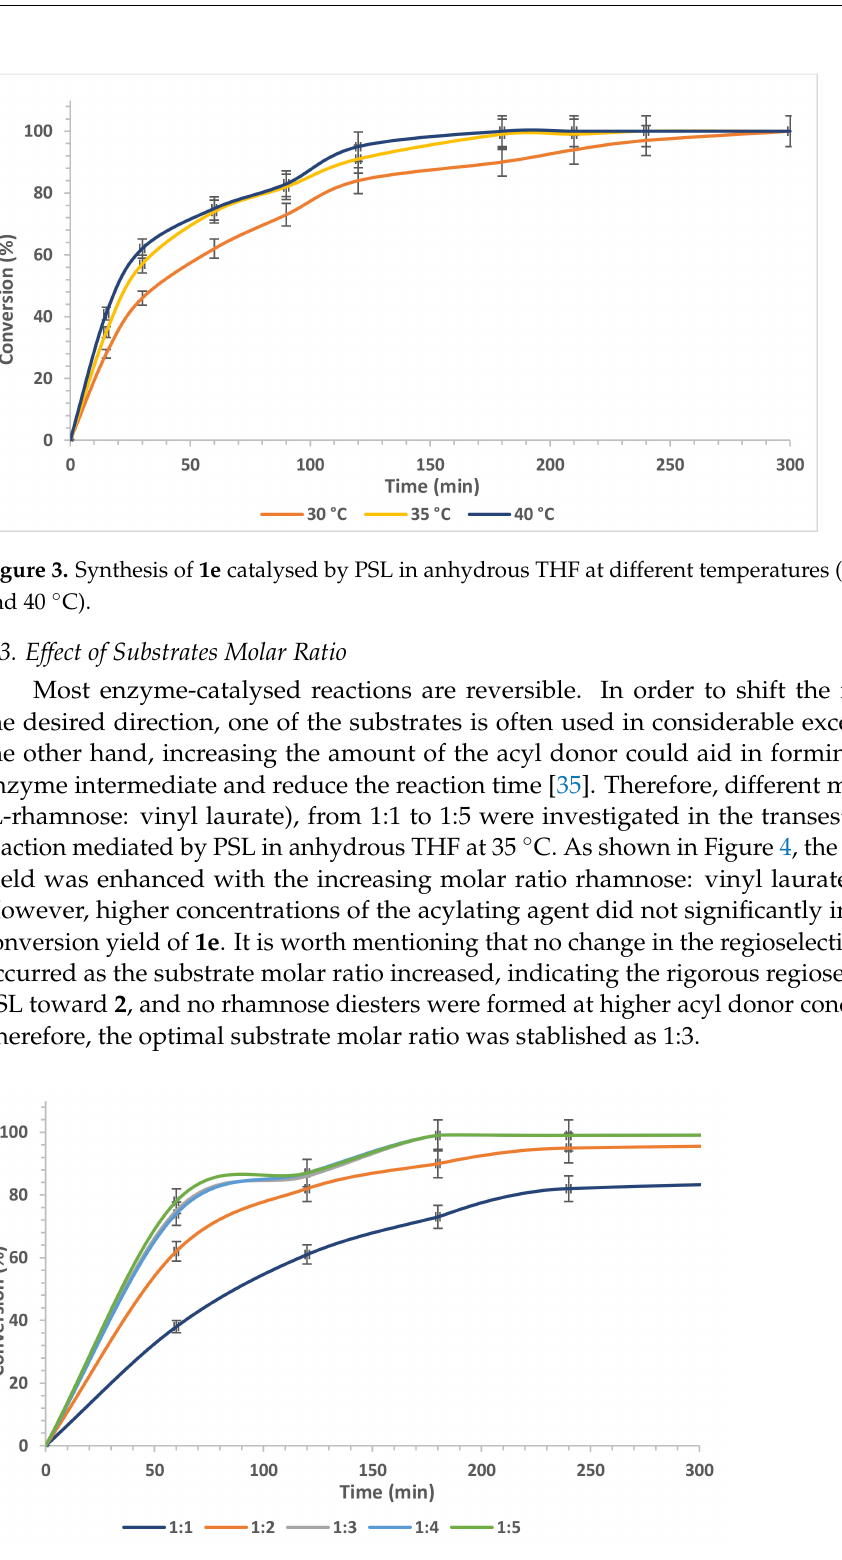
Figure 4. Influence of the substrate molar ratio (L-rhamnose: vinyl laurate) on the